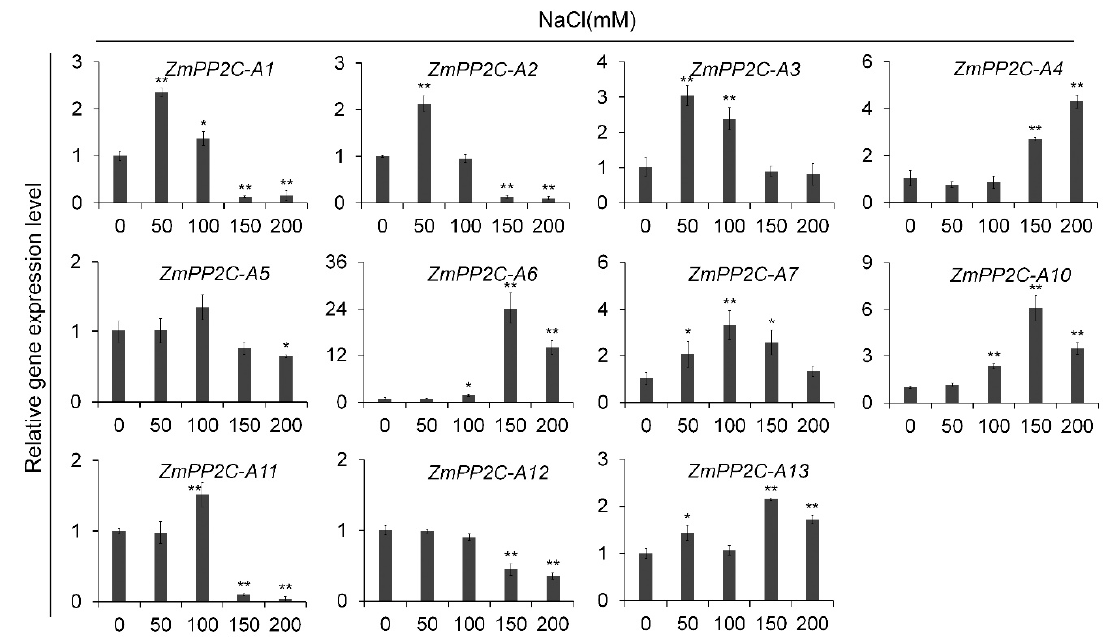
Figure 2. Relative expression of ZmPP2C-A genes to salt treatment. The relative expression levels of ZmPP2C-A genes were analyzed by qRT-PCR in maize seedlings after salt treatment. ZmActin5 gene was used as an internal control. Seedlings at three-leaf stage were subjected with various concentrations of NaCl (0, 50, 100, 150, 200 mM) solution, and samples were harvested three hours after the treatments. Data represent the mean ± SD of three replicates. Asterisks indicate the significance of T -test, * p < 0.05, ** p < 0.01.